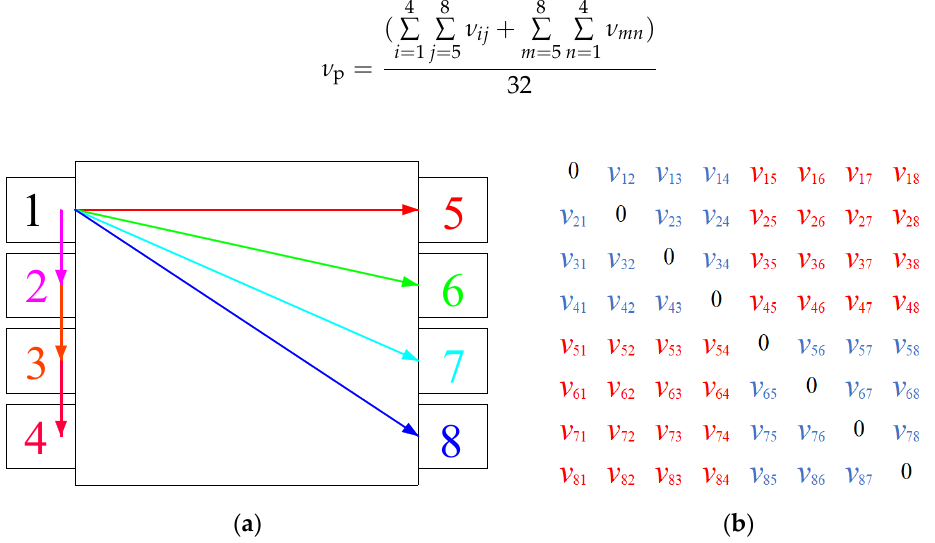
Figure 5. The calculation schematic diagram of AE wave velocity matrix. ( a ) AE signal propagation mode, ( b ) the matrix of AE wave velocity.